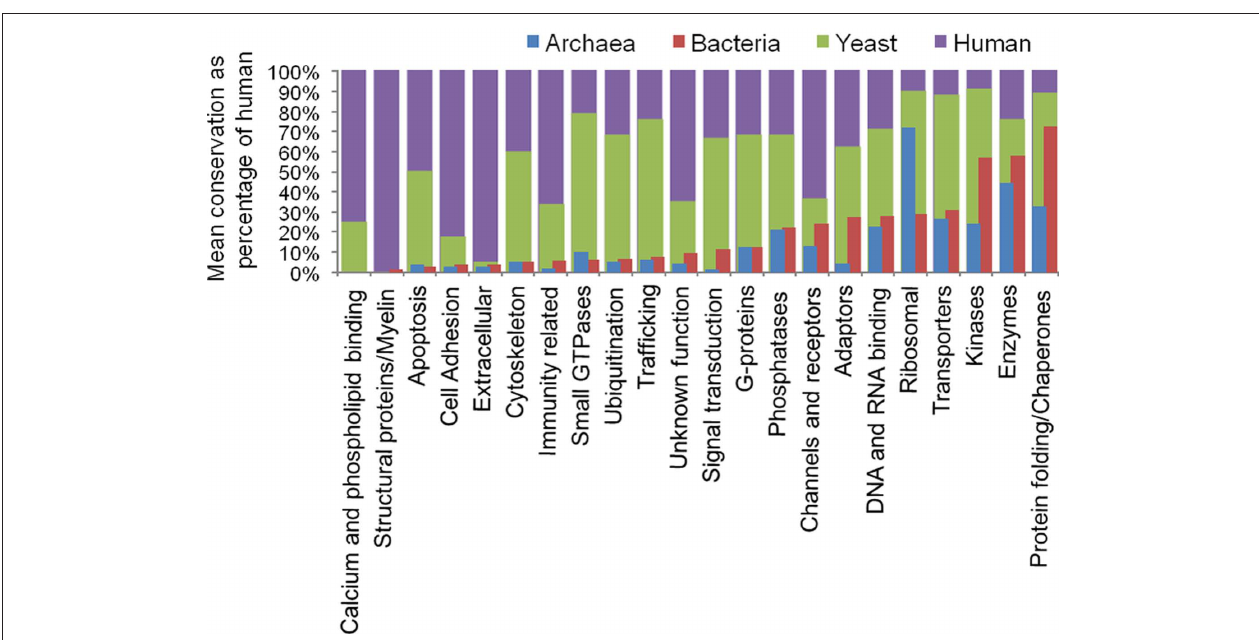
Figure 3 | Conservation of hPSD protein types. Relative composition of identified protosynapse compared to human postsynaptic density. Mean bacterial or archaeal percentage of identified homologs were compared to the percent of human genes in a protein supercategory.